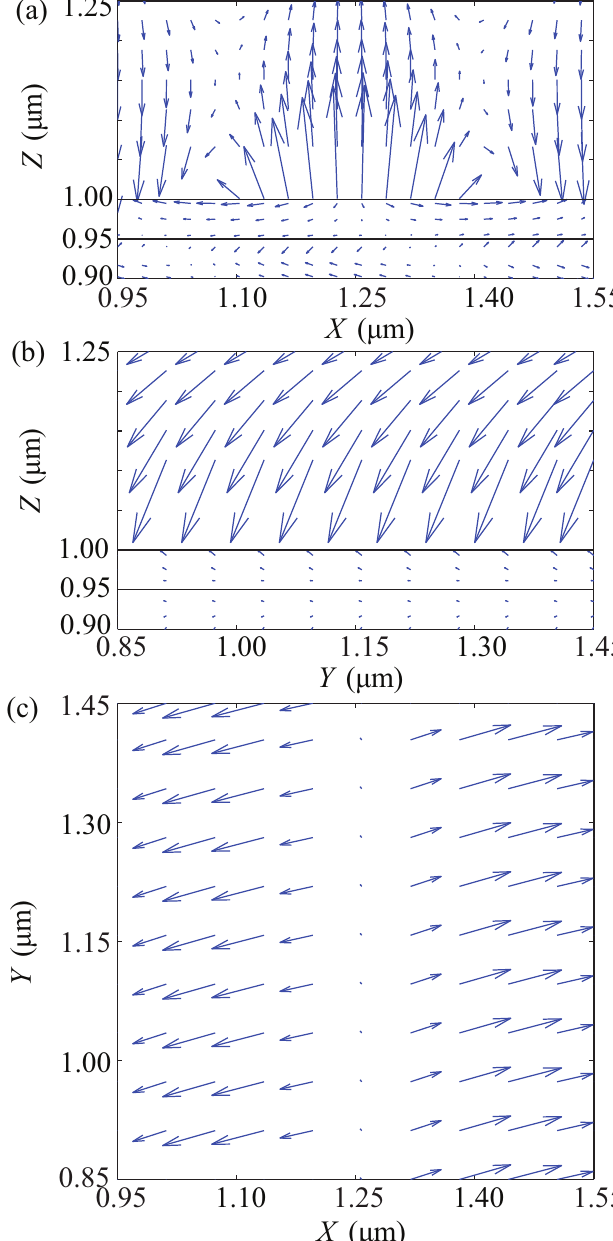
Figure 3. Field vector plots of the electric field E for hybridized surface plasmonic polaritons (HSPPs) excited at the reflectance dip in Figure 2a. ( a ) (cid:126) E × 3 . 5 in XZ plane; ( b ) (cid:126) E × 3 . 5 in Y Z plane; ( c ) in XY plane. Values of the electric field in XZ plane and Y Z plane are expanded by factors of 3.5 for visual purposes. The electric field vectors are scaled arbitrarily and arrows show their